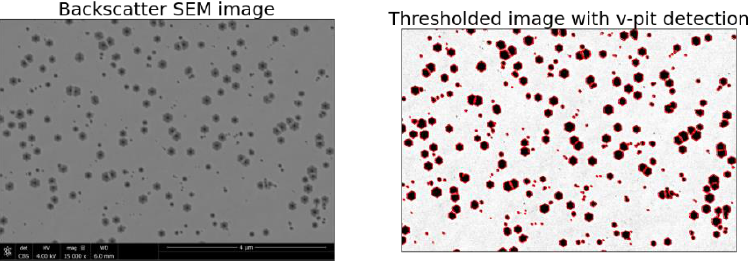
Figure 2. Backscatter SEM image showing V-defects before and after image processing